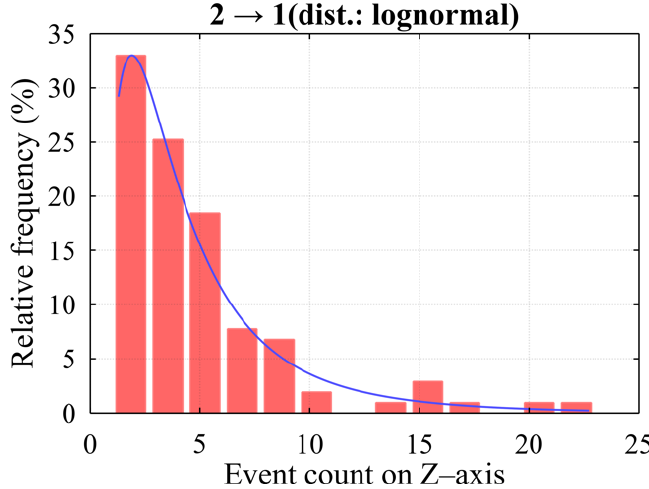
Figure 27. Histogram of detected impacts (events).